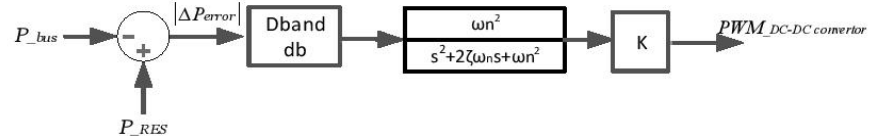
Figure 7. Schematic of the VSP-based FAPR.